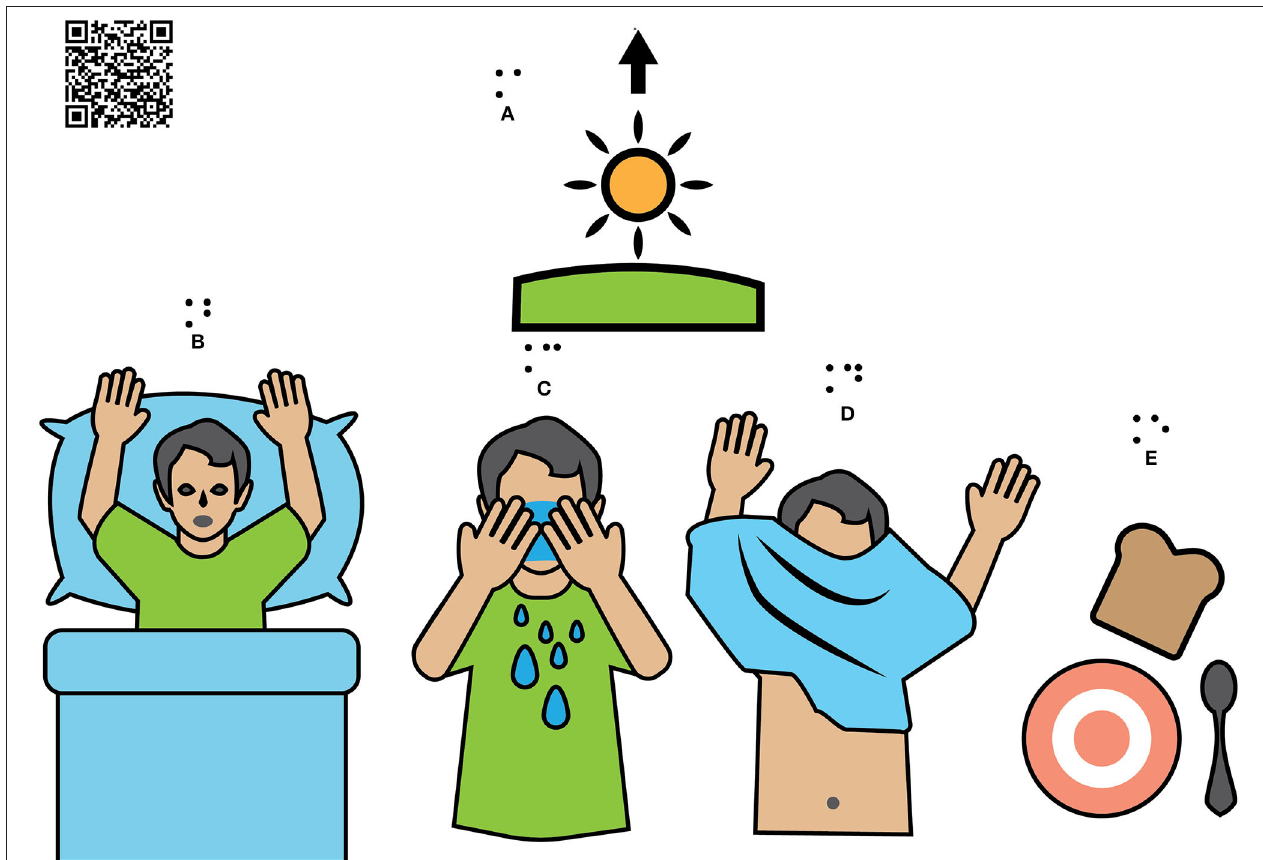
FIGURE 1 | Sequencing the day’s